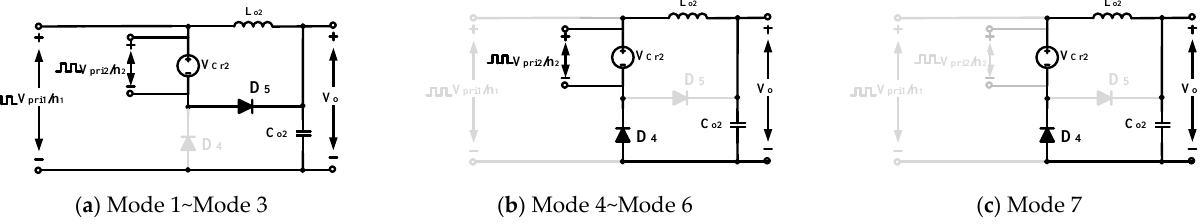
Figure 5. Simplified circuit model of the LDC converter: ( a ) power transfer mode in both converters, ( b ) power transfer mode in forward converter and freewheeling mode of PSFB converter, ( c ) freewheeling mode of both converters.